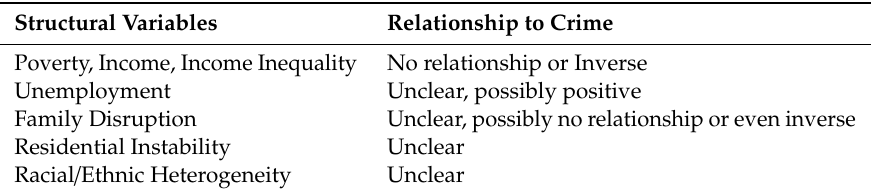
Table 2. Social disorganization variables e ff ects on rural crime